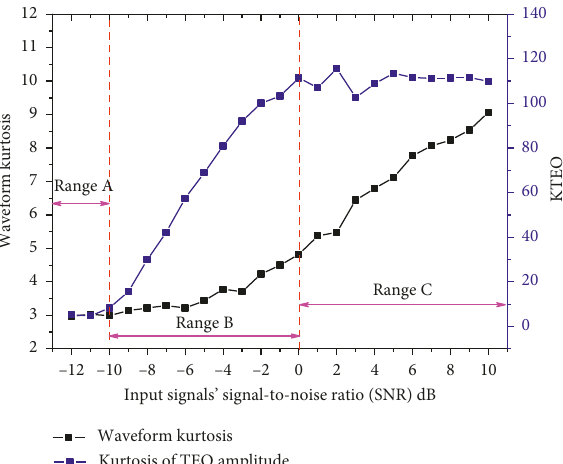
Figure 3: Waveform kurtosis and kurtosis of TEO amplitude variation with signal-to-noise